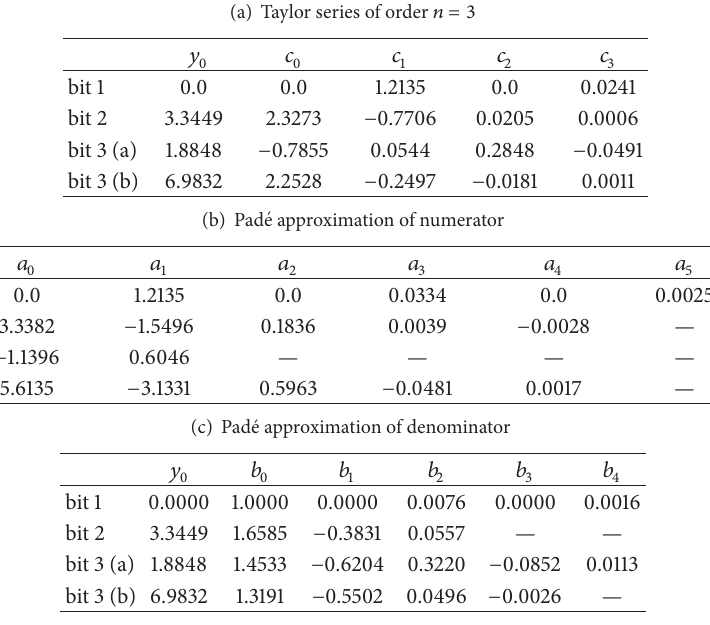
Table 2: Comparison between the iterative thresholds for LDPC code ensembles using different LLR calculation